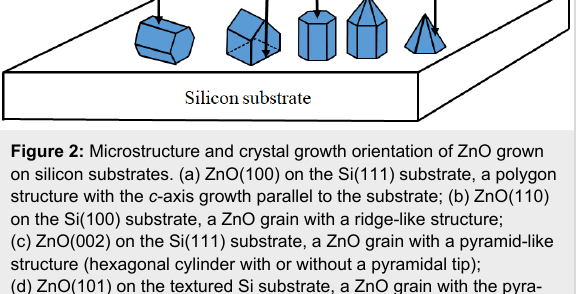
The microstructure and crystal growth orientation of